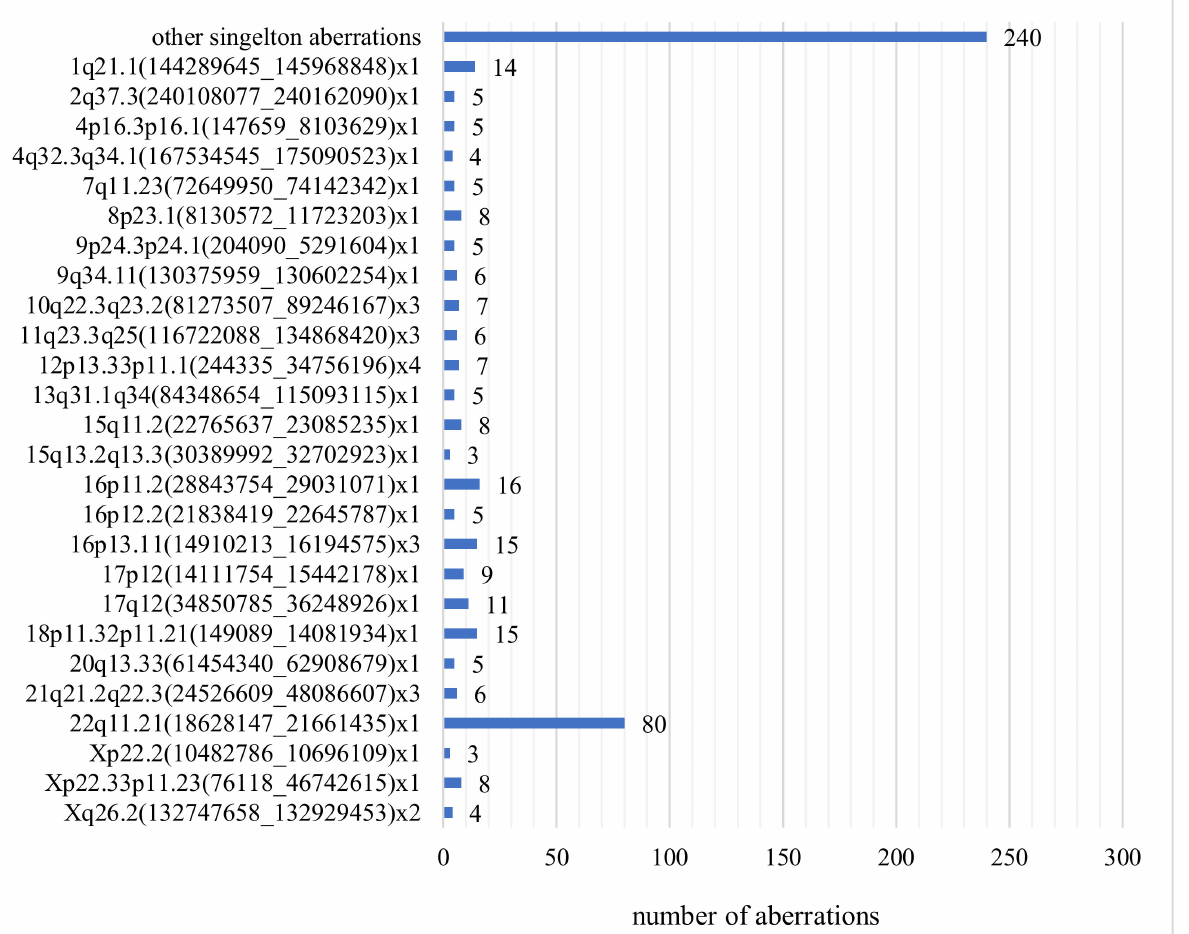
Figure 3. Number and type of clinically relevant CNVs. The 18p11.32p11.21 deletion was found in 15 fetuses (15/7400, 0.21%) with increased